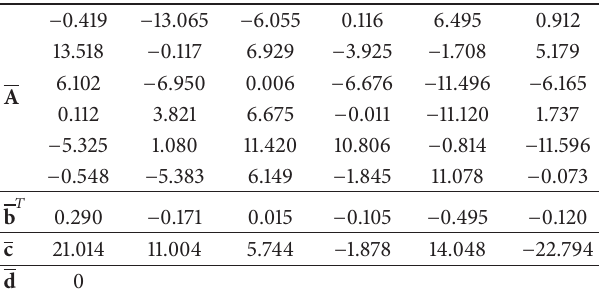
Table 4: Identification result for Case 1